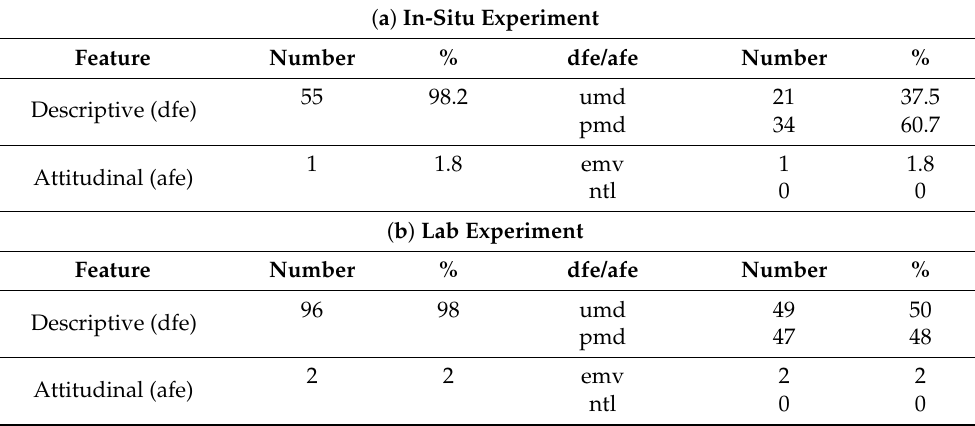
Table 1. Distribution of attributes in different categories after